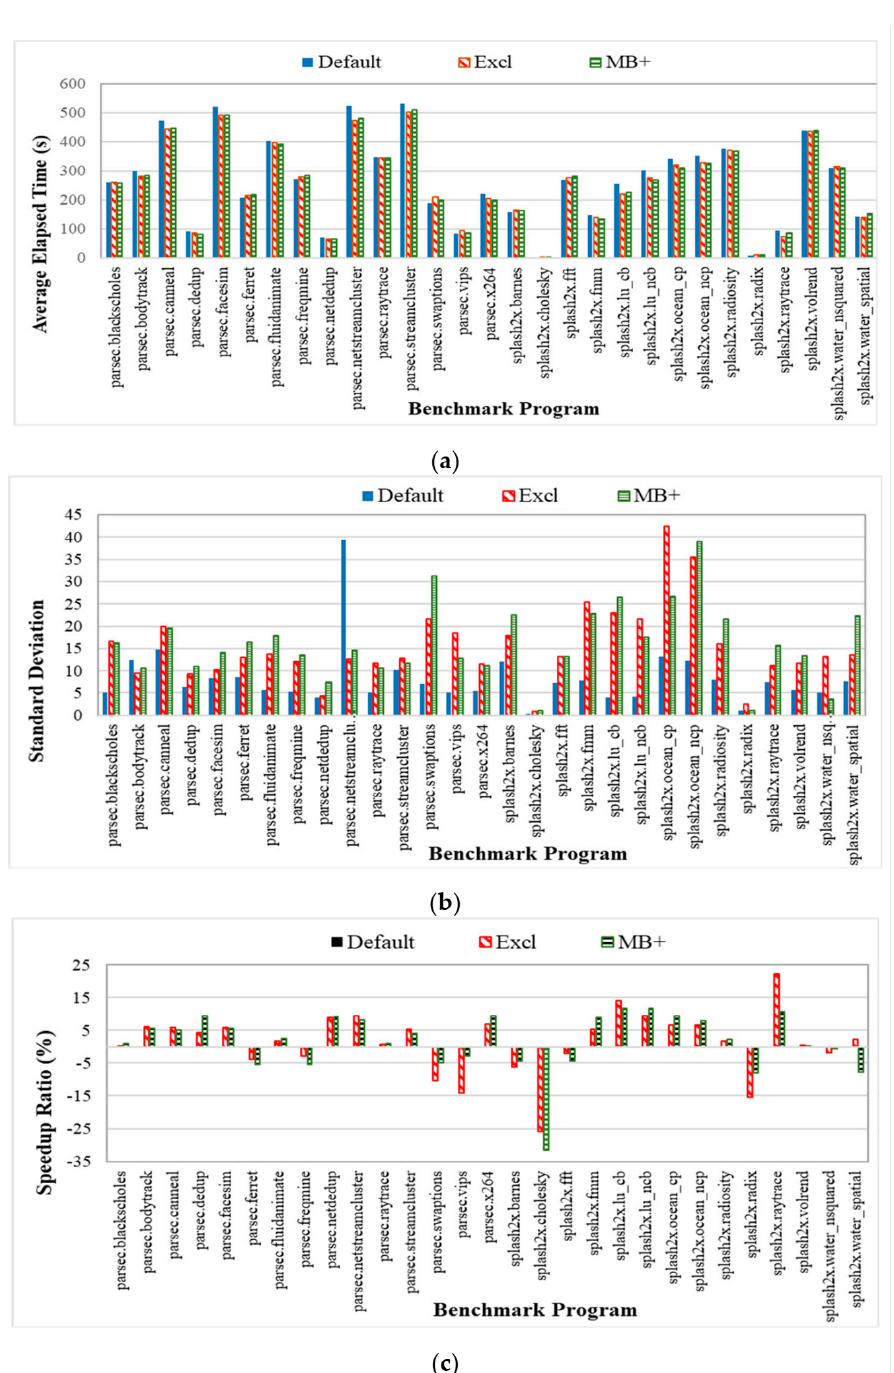
Figure 14. Experimental results for systems running each benchmark program. ( a ) The average elapsed time; ( b ) The standard deviation in the running time; ( c ) The speedup ratio. However, the parallel computing capability of a multi-core system is limited and depends on the number of cores in the target system. If there are too many threads running, contention for cores and memory resource slows down the performance. On the contrary, if there are too few or no threads wait in runqueue, task selection policies are not